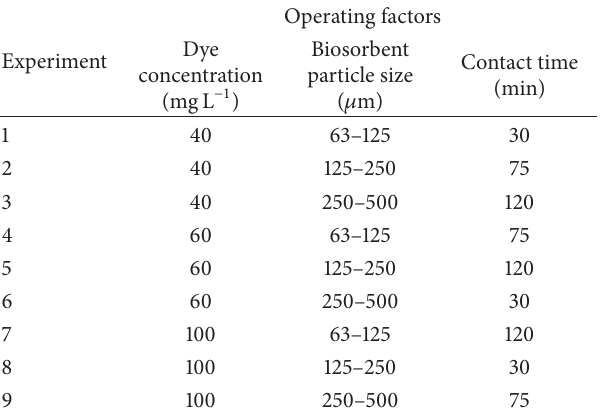
Figure 2: SEM picture of pine cone shell. (3 3 ) orthogonal array design. Table 1: Taguchi L 9